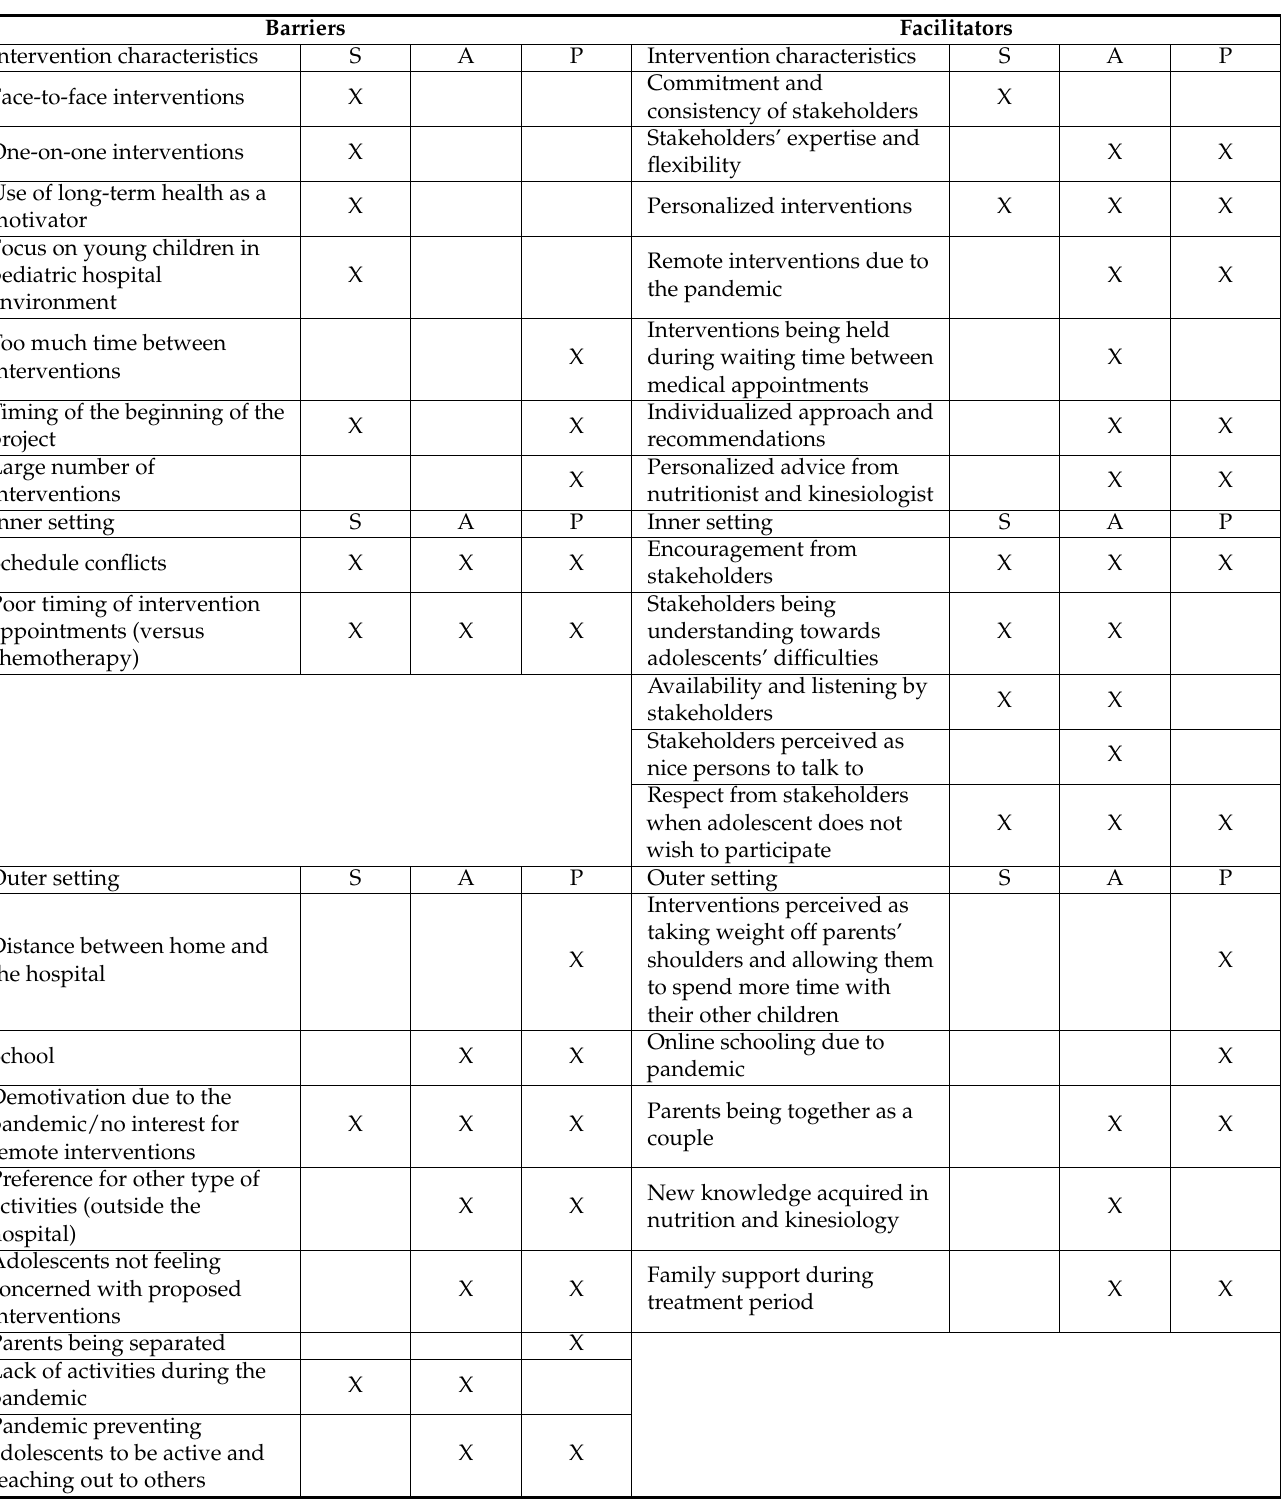
Table 3. Perceived barriers and facilitators to adolescents’ participation health promotion interven- tions in